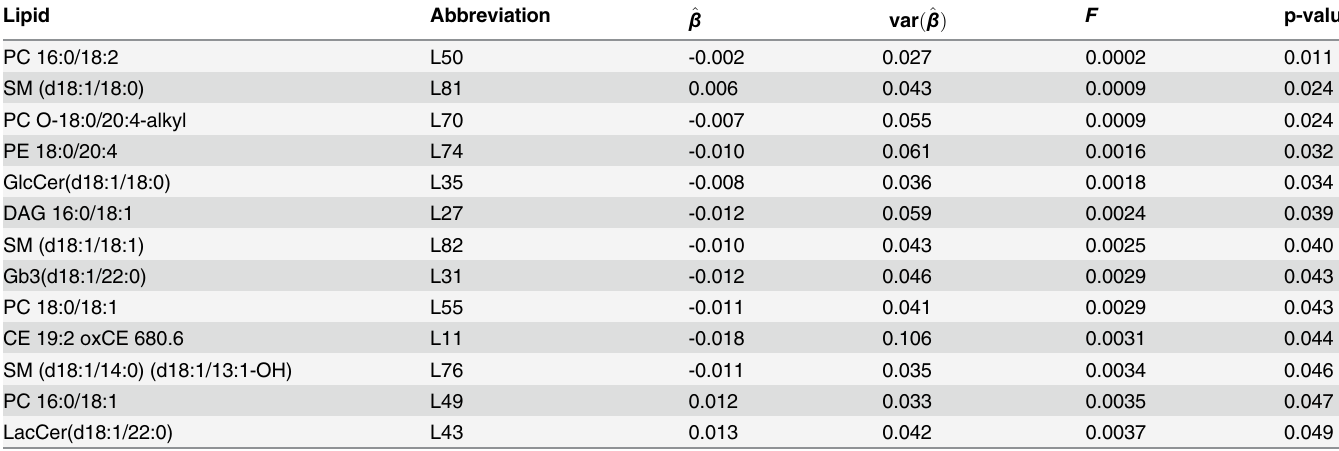
Table 3. The 13 imputed lipids having significantly different mean concentrations between case and control groups by the marginal analysis imple- mented by using Rubin ’ s rules.